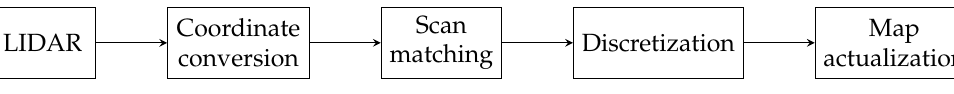
Figure 2. Overview of the